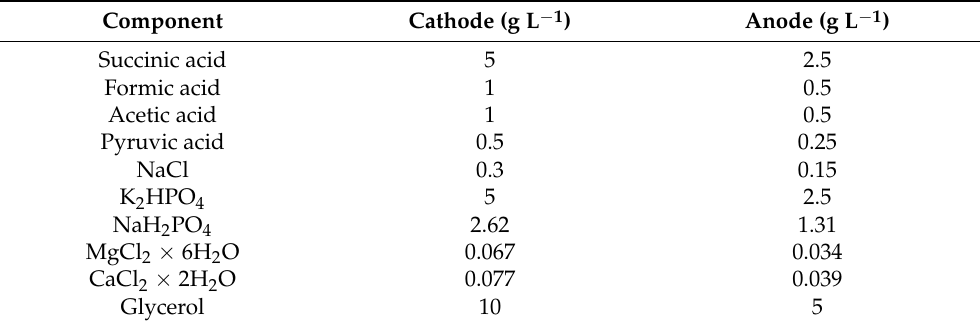
Table 4. Initial composition and concentration of synthetic broth of A. succinogenes based on Ferone [21] at the onset of the experiment in the anode and cathode